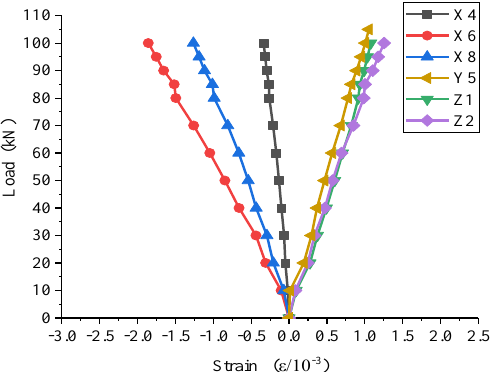
Figure 21. Load–strain curve of S1, areas X, Y, Z.